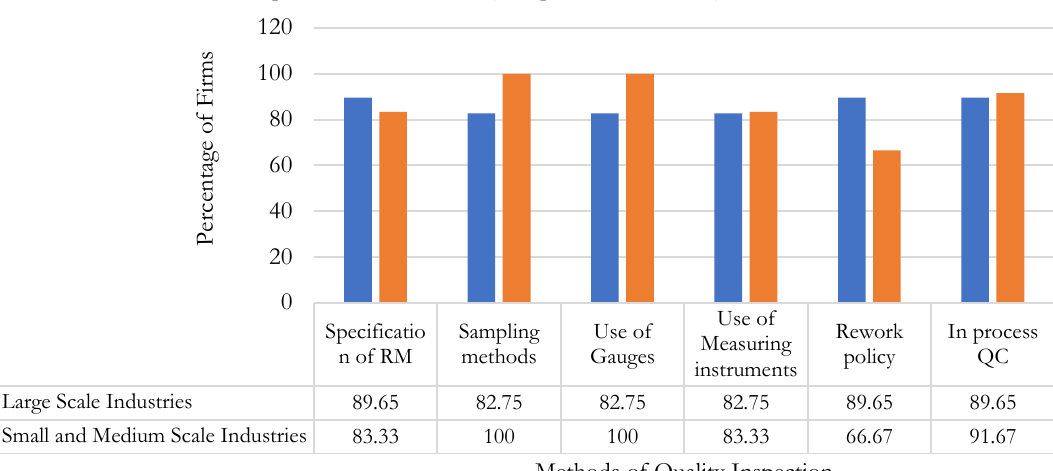
Fig. 9. Methods of quality inspection: comparison between both groups of